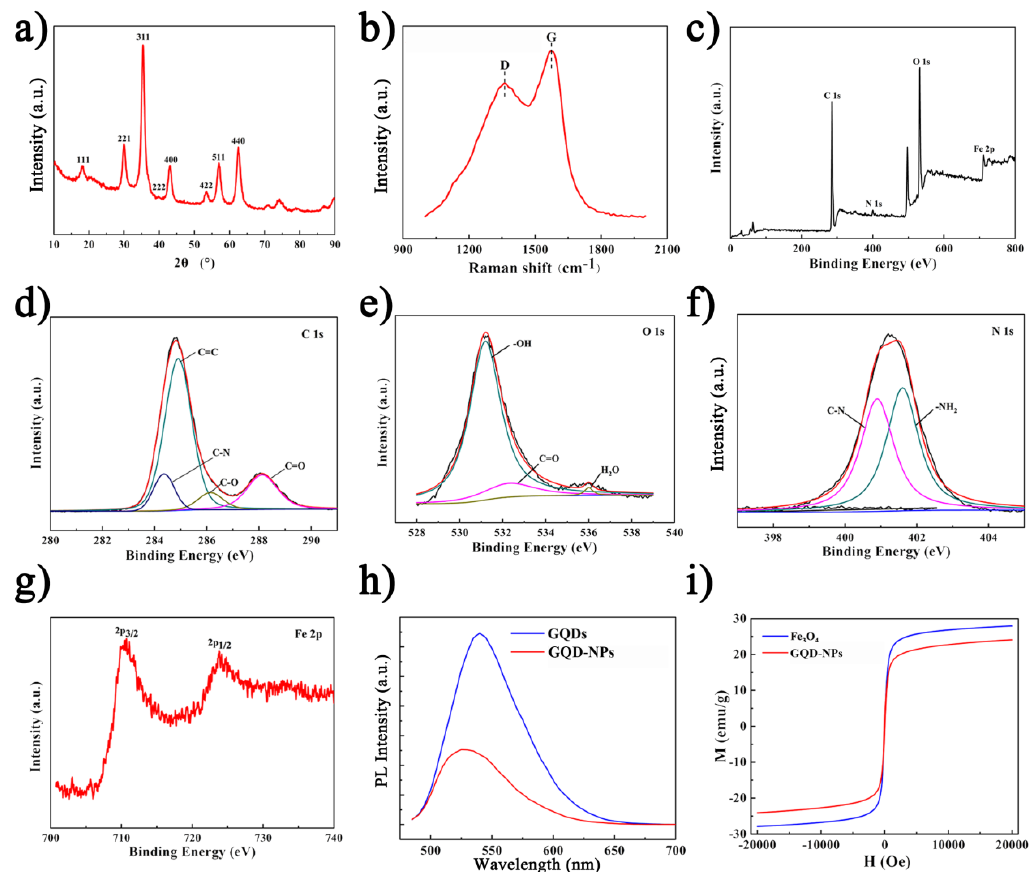
Figure 2. Properties of GQD-nanoparticles (NPs): ( a ) X-ray di ff raction (XRD) patterns; ( b ) Raman spectrum, the ordered G band and disordered D band were indicated; ( c ) X-ray photoelectron spectrum (XPS); ( d – g ) XPS analysis of C, O, N and Fe, respectively; ( h ) Photoluminescence (PL) spectra with the pulsed laser excitations at 490 nm; ( i ) Magnetizing curve, magnetization (M), magnetic field strength (H).